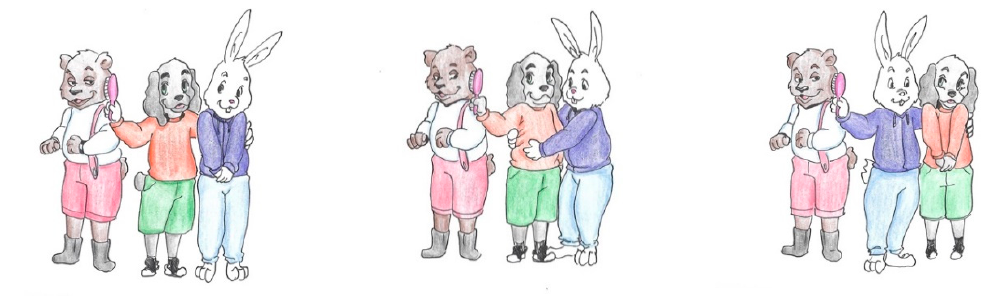
Figure A10. SRC stimulus 5.